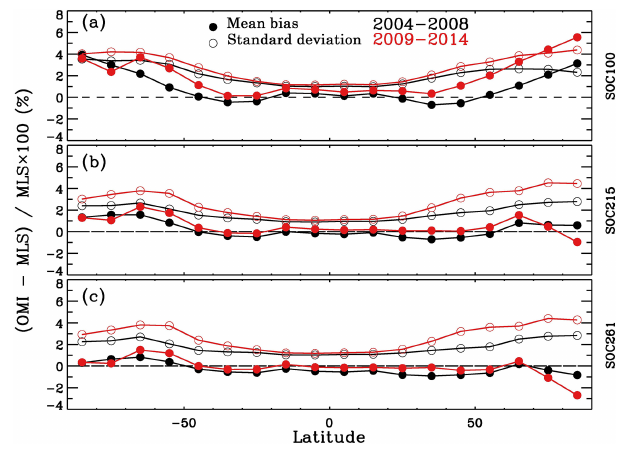
Figure 8. Mean biases (solid circles) and standard deviations (open circles) of the differences between OMI and MLS strato- spheric ozone columns (SOCs) above 100hPa (a) , 215hPa (b) , and 261hPa (c) as a function of latitude, during 2004–2008 (black) and 2009–2014 (red). Please noted that standard deviations are plotted with the zero line as a